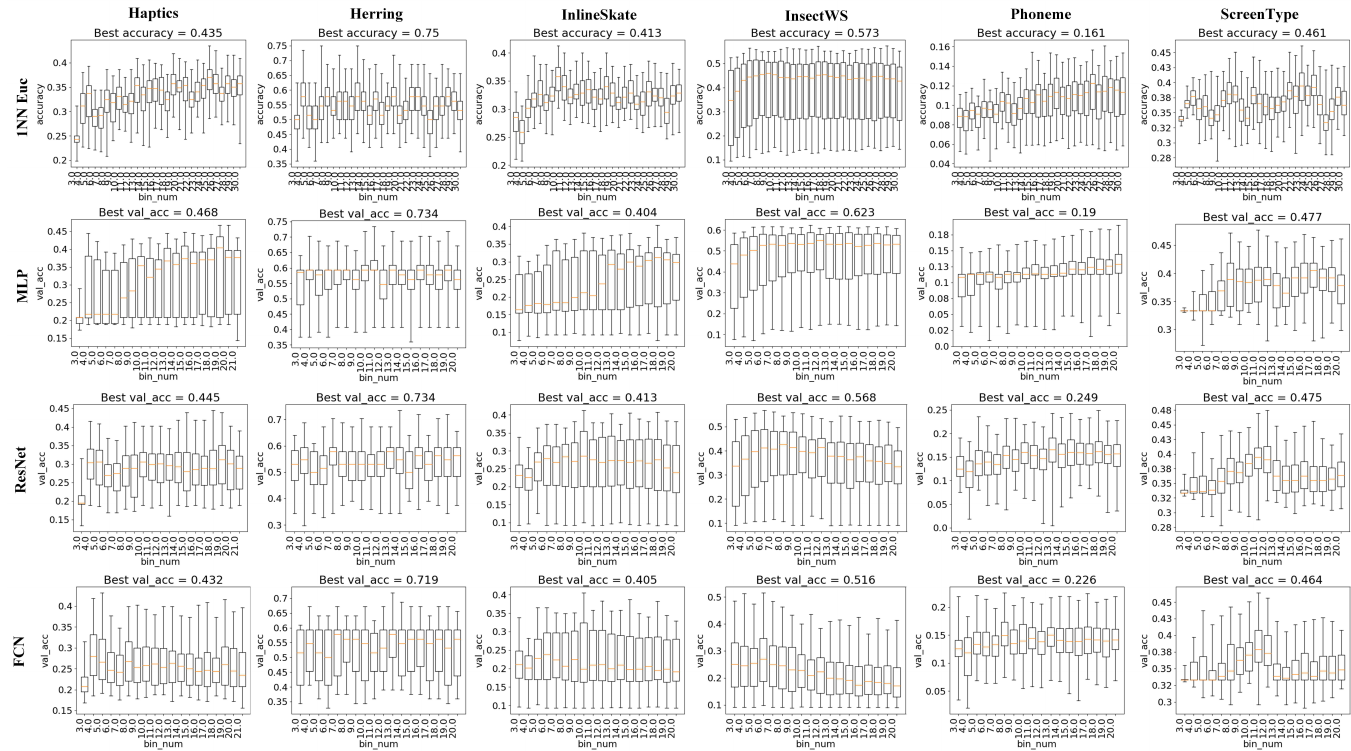
Figure 8. Impact of bin number on TSC